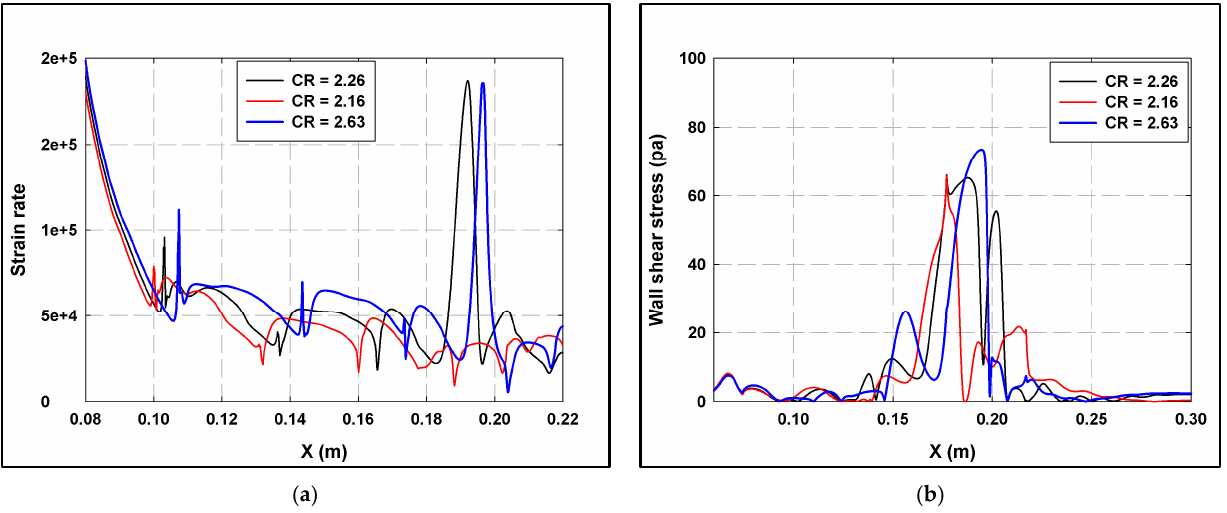
Figure 2. Shear strain rate profiles ( a ) and Wall shear stress distribution ( b ) for the CF2I2-CH3OH fluid pair.